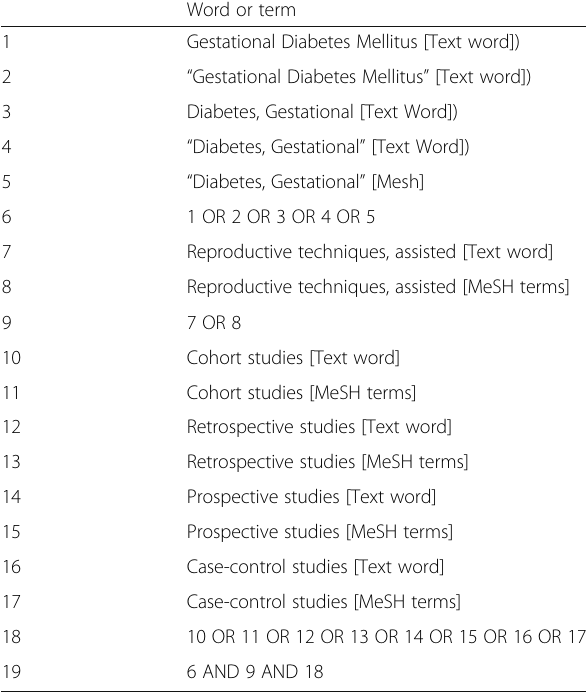
Table 1 Search strategy for MEDLINE (MeSH, Medical Subject